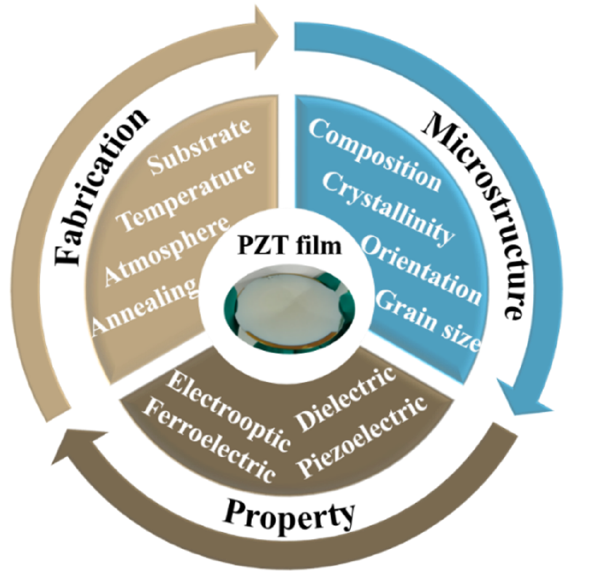
Figure 12. Relationships between fabrication, microstructure and property of PZT film. Picture in the center represents PZT thin film on 3-inch platinized silicon substrate by magnetron sputtering technique in our group.